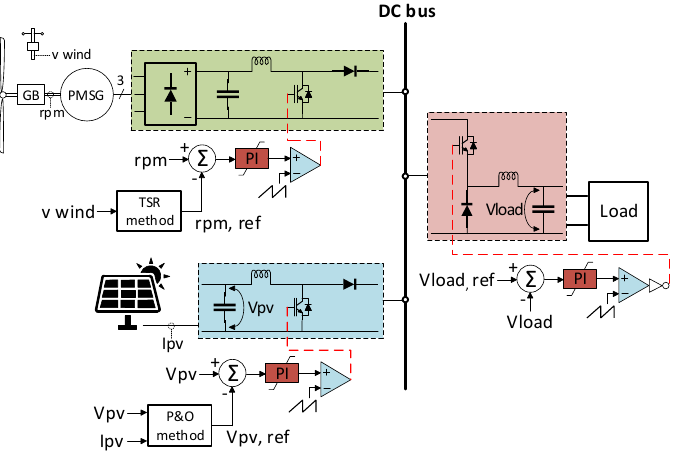
Figure 4. The control techniques for PV, WTG, and load.